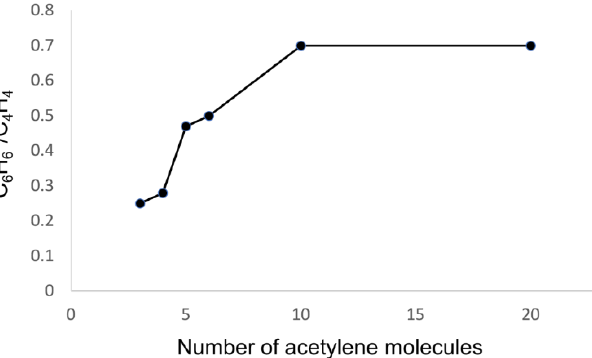
Figure 7. The C 6 H 6+ /C 4 H 4+ ratio as a function of the number of acetylene units in the cluster.